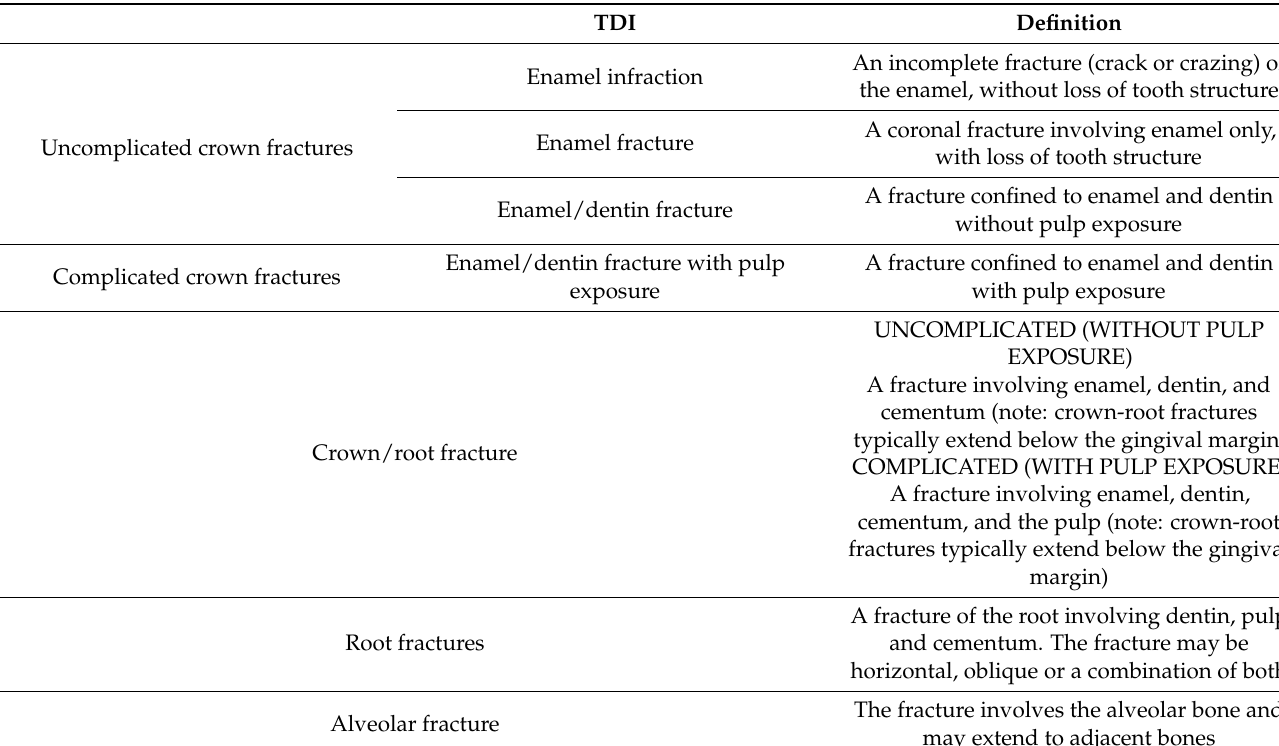
Table 1. List of traumatic dental injuries related to teeth and periodontal structures. Adapted from Levin L. et al. [15] and Bourguignon, C. et al. [16].